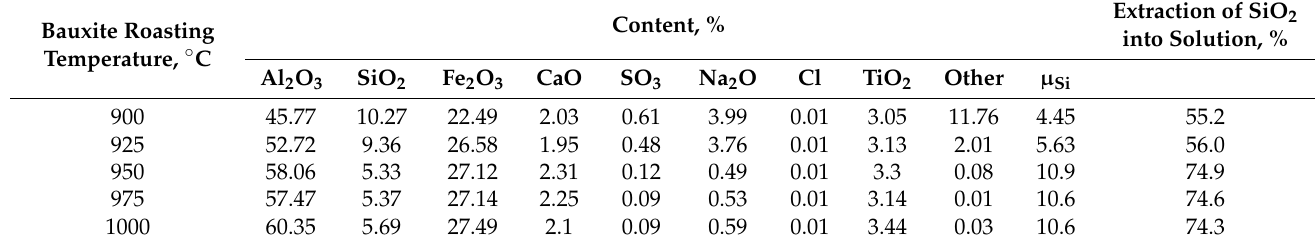
Table 1. The composition of bauxite after chemical beneficiation (with Extraction of SiO 2 into solution). Content, % Bauxite Roasting Temperature, ◦ C